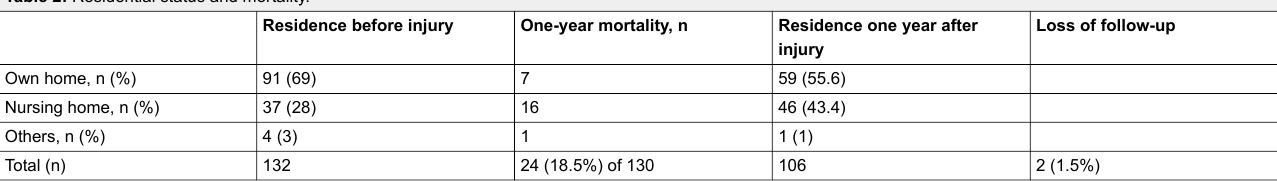
Residence before